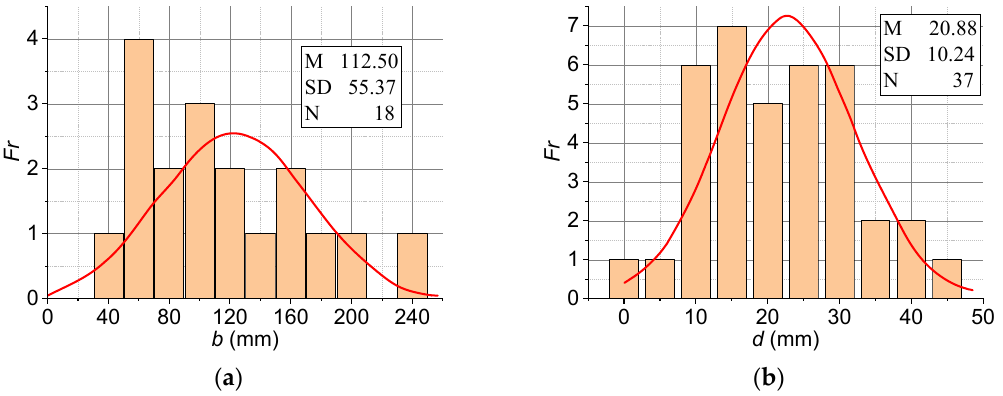
Figure 8. Frequency: ( a ) histograms regarding the values of the measurements b ; ( b ) d stipulated for the numerical simulations of the beams.